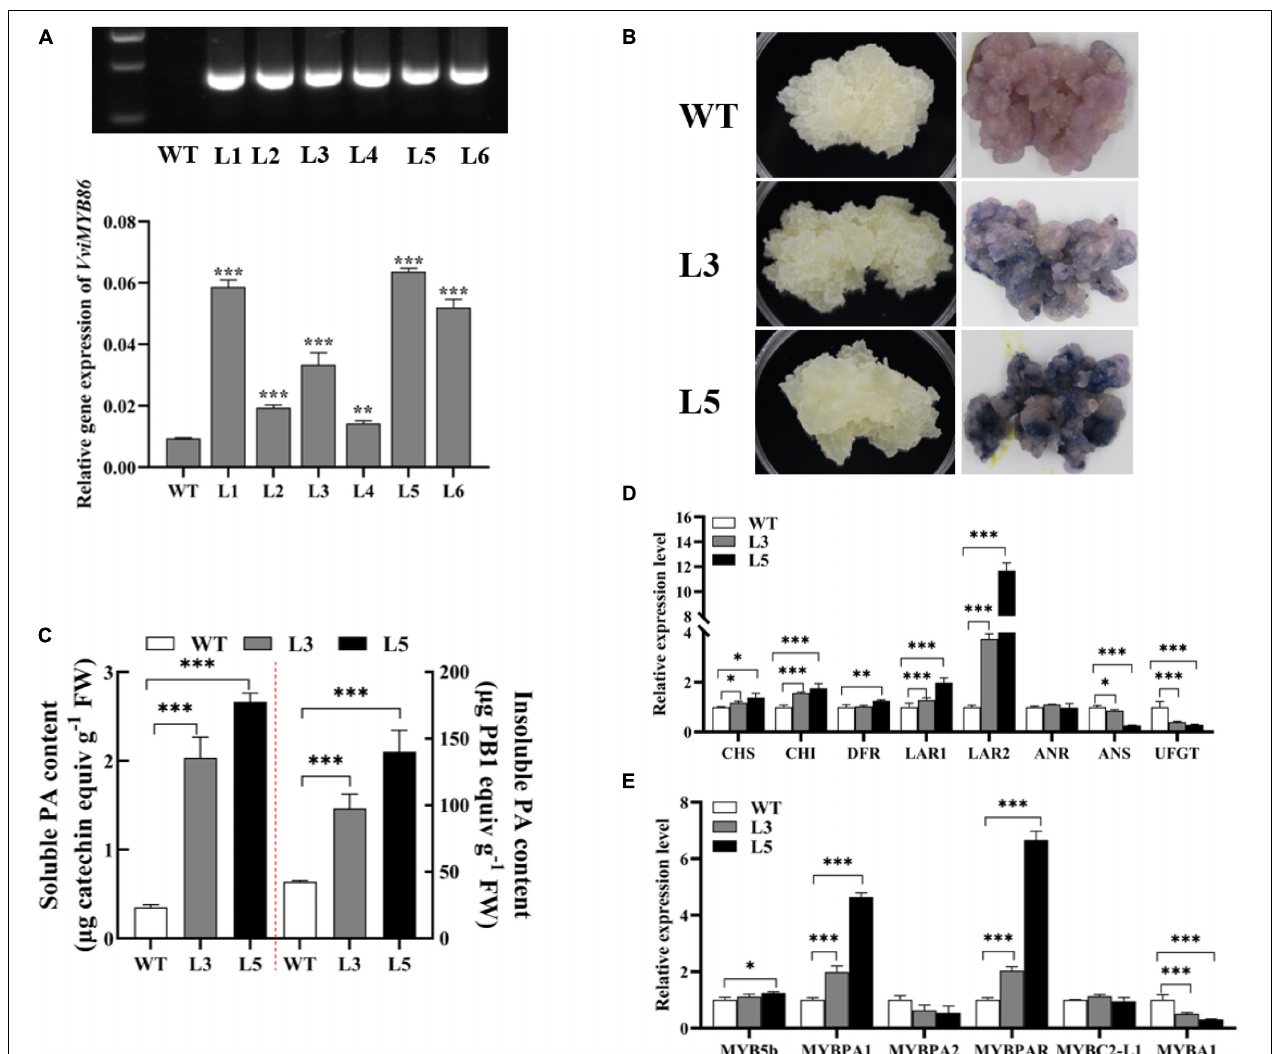
FIGURE 5 | VviMYB86 positively regulated proanthocyanidin (PA) synthesis in grape callus. (A) Identification of transgenic callus. The top was hygromycin gene expression detected by PCR and analyzed by gel electrophoresis. The below was the expression level of VviMYB86 in wild type (WT) callus and different transgenic lines (L1-L6). The value above the column referred to the transcripts of VviMYB86 in transgenic and WT calluses cultured under dark conditions. (B) The photos of WT callus and two independent VviMYB86 transgenic lines (L3 and L5). The left was WT callus and transgenic lines in their natural growth states cultured in darkness. The right was WT callus and transgenic lines after 4-Dimethylaminocinnamaldehyde (DMACA) staining. (C) The soluble and insoluble PA content in the WT callus and transgenic lines. FW, fresh weight. Data was expressed as means ± SD of three replicates. Asterisks indicated significant differences relative to the control by one-way ANOVA test ( ∗∗∗ p < 0.001). (D) The relative expression of flavonoid pathway related structural genes. After several successive rounds of subculture, stable transgenic callus lines were established on selectable medium. Callus grown for 25 days was collected for each assay. CHS, chalcone synthase; CHI, chalcone isomerase; DFR, dihydroflavonol-4-reductase; LAR, leucoanthocyanidin reductase; ANR, anthocyanidin reductase; ANS, anthocyanidin synthase; UFGT; UDP-glucose: flavonoid-3- O -glucosyltransferase. (E) The relative expression of known flavonoid regulators. Data was expressed as means ± SD of three replicates. Asterisks indicated significant differences relative to the control by one-way ANOVA test ( ∗ p < 0.05; ∗∗ p < 0.01; ∗∗∗ p <